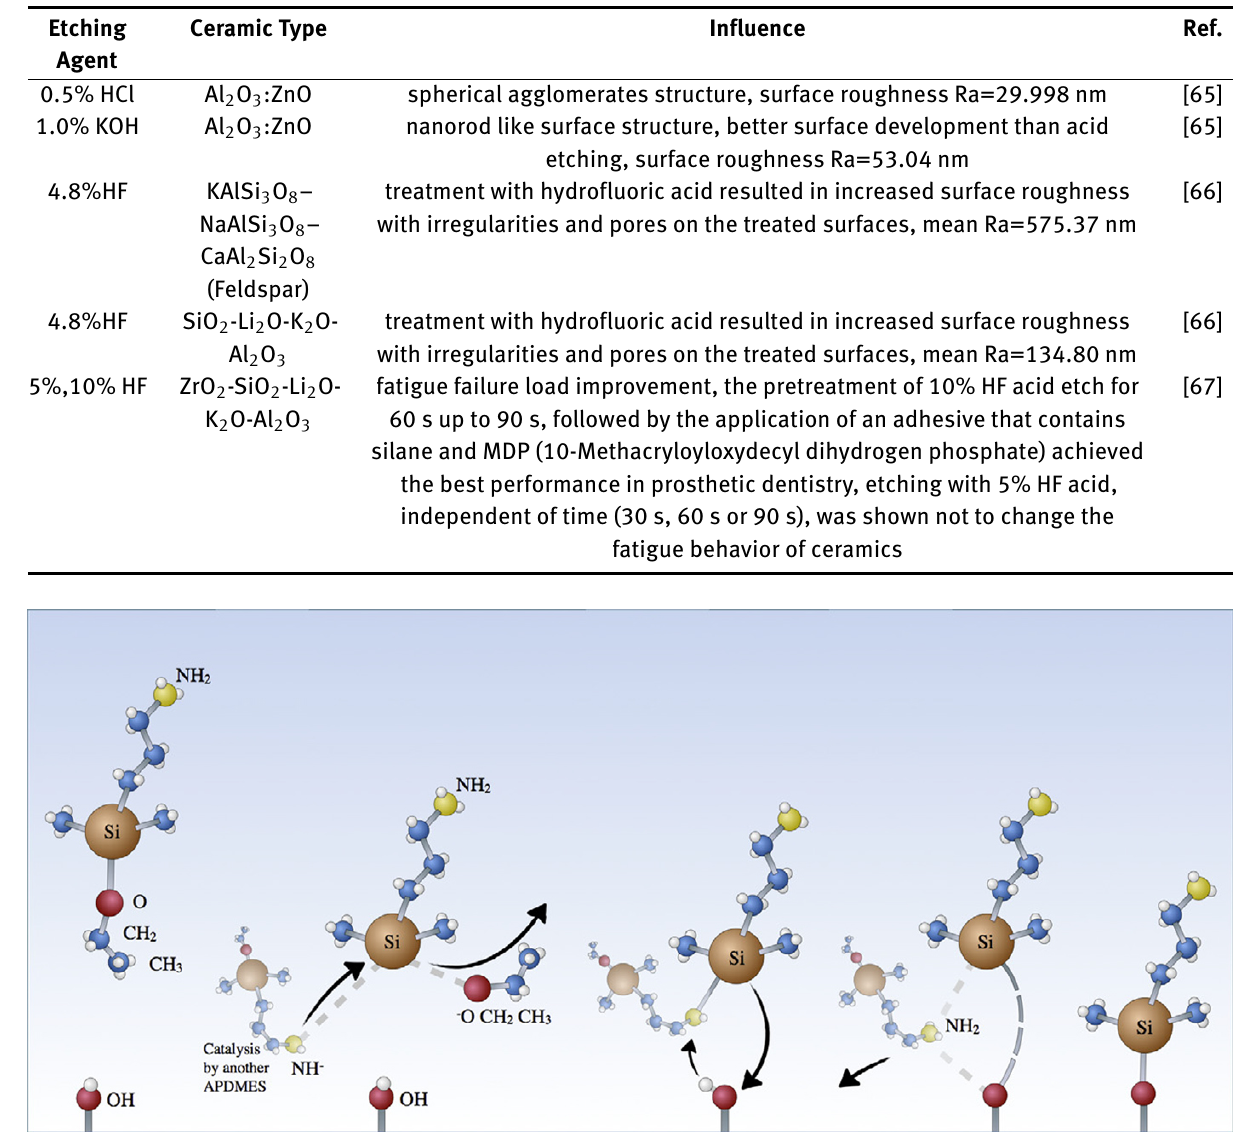
terest in terms of ceramic material surface modification to promote and improve adhesion to different resins, espe- cially in prosthetic and general dentistry [68]. Silane com- pounds are commercially available, bearing amino, thiol, carboxyl, epoxide, etc. [68]. The silanization process is ini- tialized by hydrolyzation of the alkoxysilane